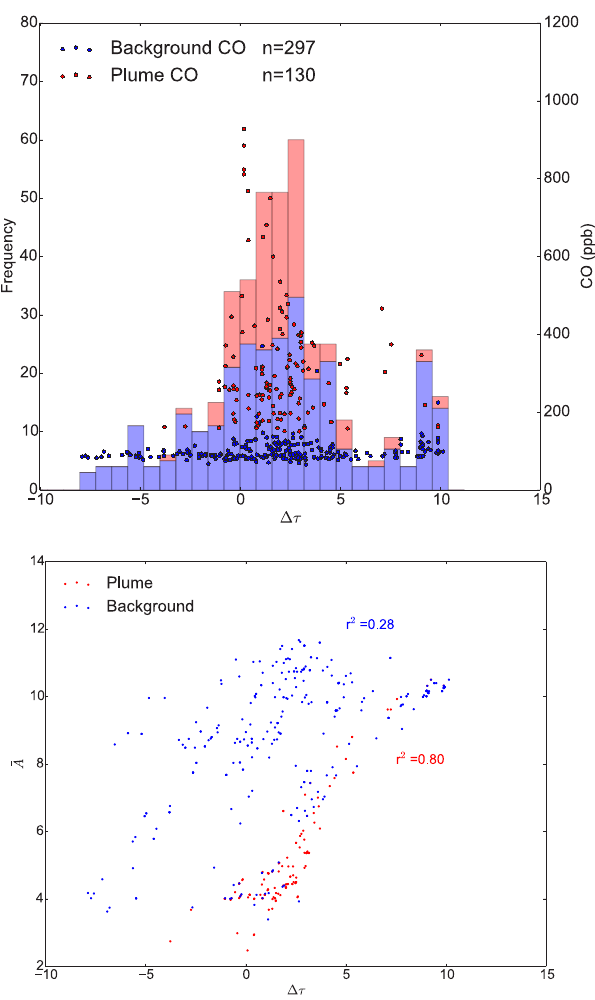
Figure 9. Top panel: frequency of effective age ¯ A minus photo- chemical age (days, left axis) and CO concentration (ppb, right axis). The number of measurements n for each classification is shown. Bottom panel: scatter plot of (cid:49)τ and ¯ A . Red dots denote CO concentrations within a plume (CH 3 CN > 150ppt); blue dots denote CO concentrations outwith a